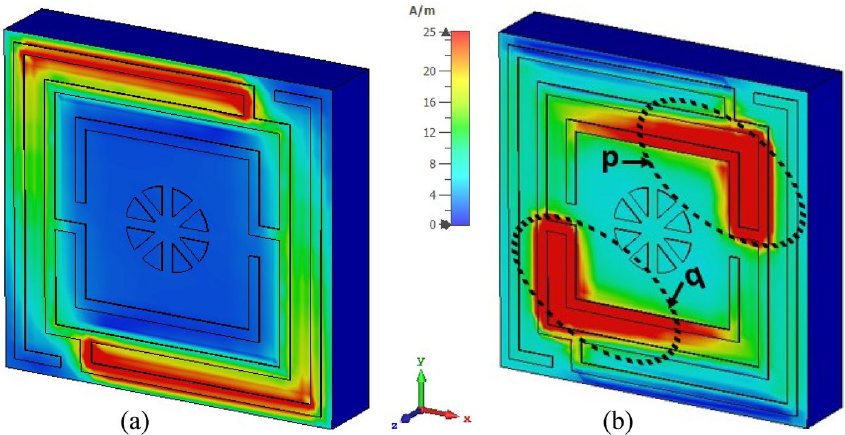
Figure 13. H-field distribution for the presented MM structure at ( a ) 3.37 GHz and ( b ) 5.8 GHz (CST STUDIO SUITE 2019, https:// www. 3ds. com/ produ cts- servi ces/ simul ia/ produ cts/ cst- studio- suite) 39 .